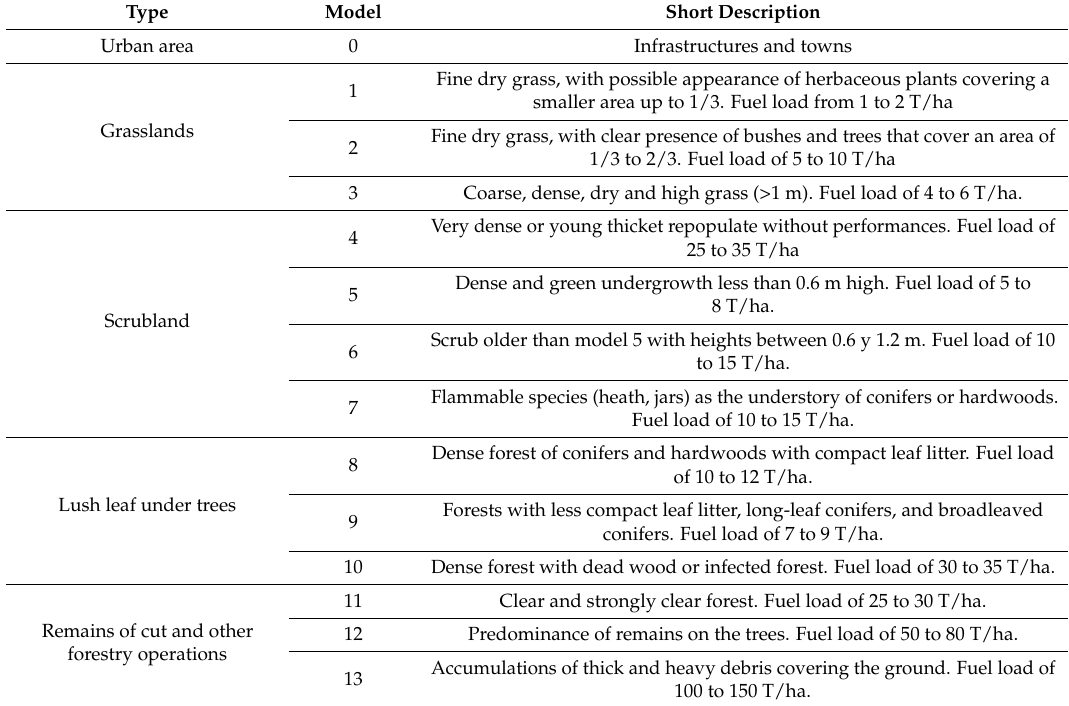
Table 3. Characteristics of fuel